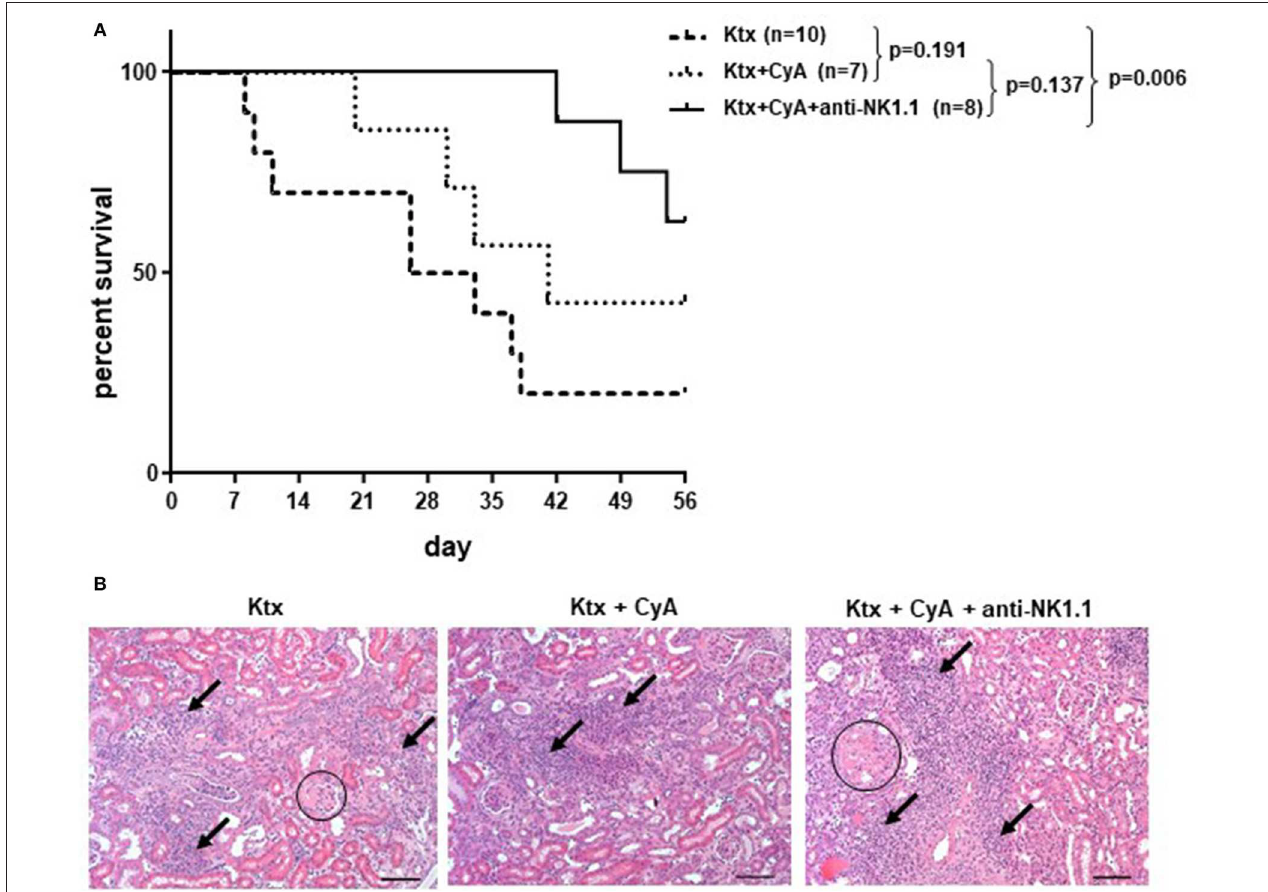
FIGURE 7 | CyA and NK cell depletion prolongs renal allograft survival. (A) Compared with recipients left untreated, NK cell depletion in combination with CyA resulted in significantly improved long-term survival of kidney grafts until POD56. Contrarily, recipients receiving CyA did not demonstrate significantly improved graft survival as compared with naïve control recipients (median survival 41 vs. 29.5 days). The survival data were analyzed by Log-rank test and are presented as Kaplan-Meier survival curve. (B) H&E stained kidney sections showing sclerotic glomeruli (circle) and interstitial inflammation (arrow) (original magnification × 250; scale bar = 100 µ m).